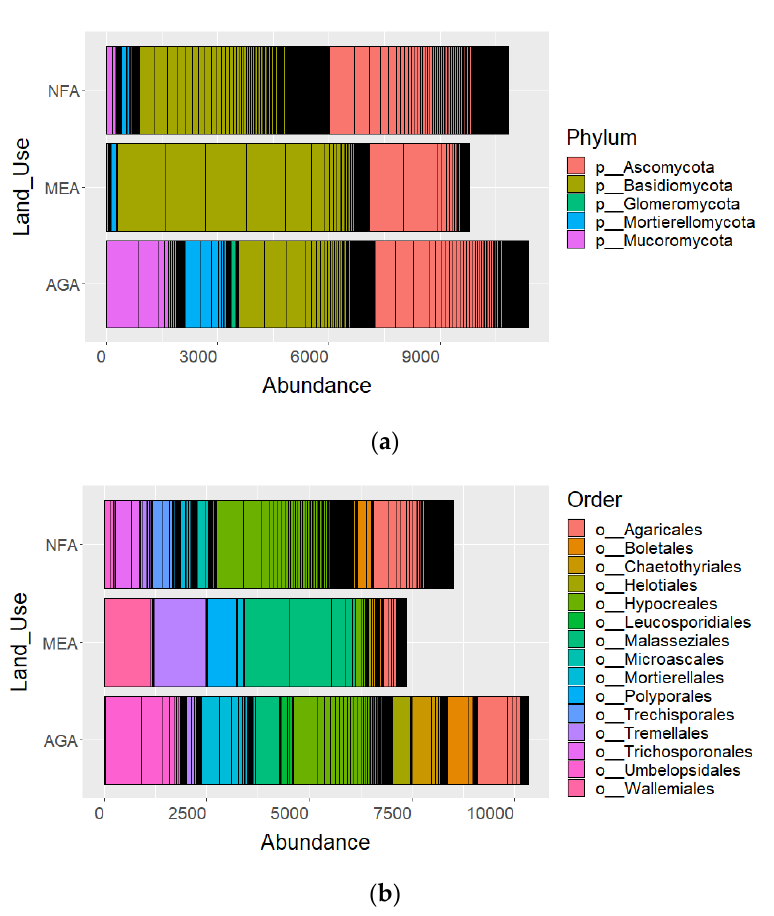
Figure 1. Abundances of fungal dominant taxa in natural forest areas (NFA), agricultural activities areas (AGA) and mining extraction activities (MEA): ( a ) abundances at phylum level; ( b ) abundances at order level. Table 1. Comparisons of OTU relative abundances at phylum level among land uses.